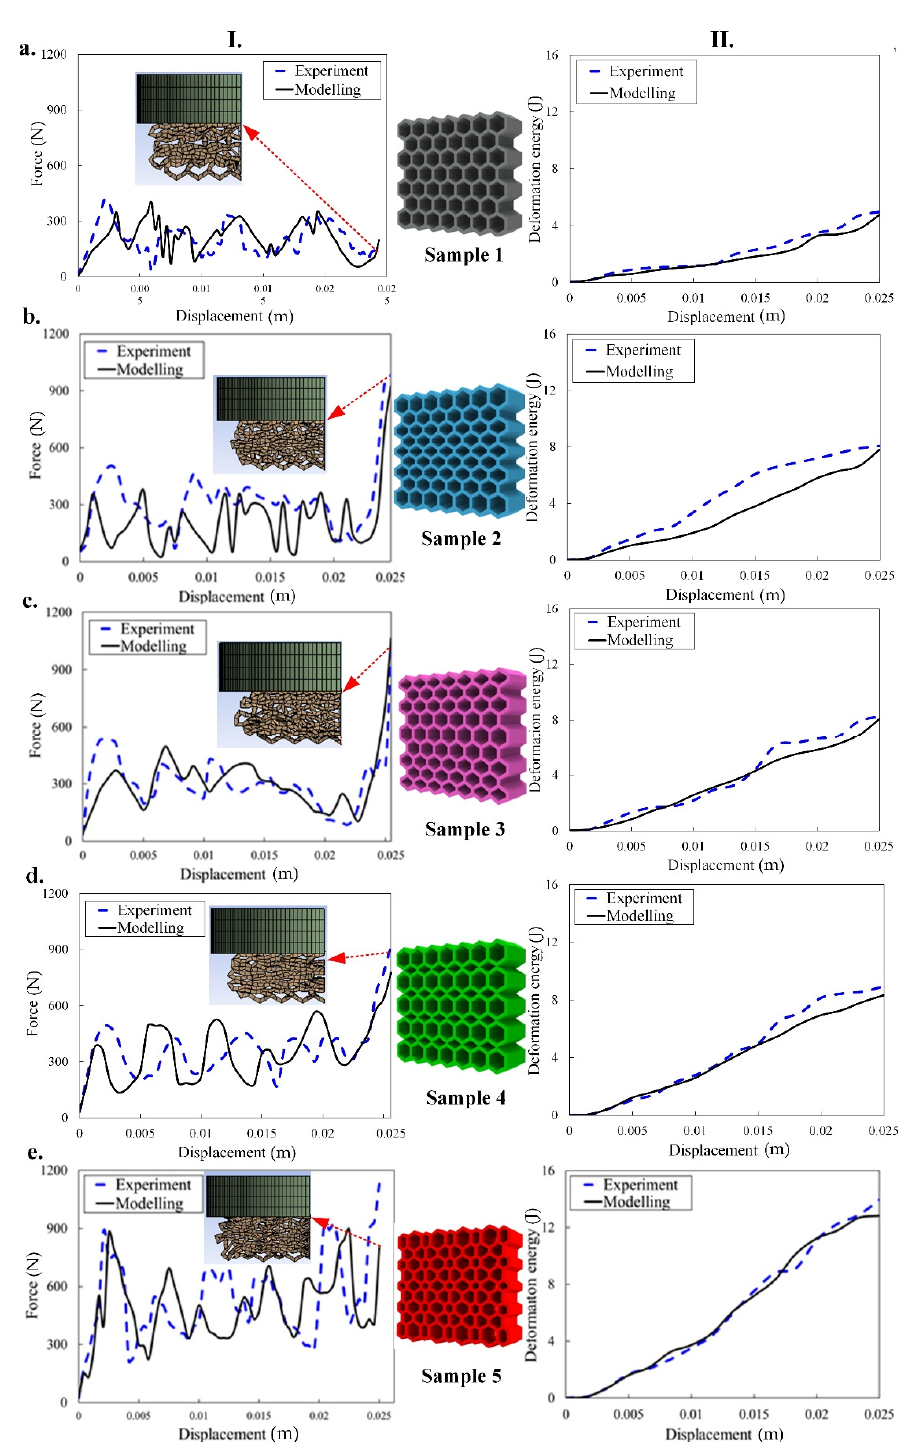
Figure 7. Experimental and numerical uniaxial force-displacement response (I) and deformation energy absorption (II) of the five samples ( a – e ) made of PA12 under a quasi-static compression test.